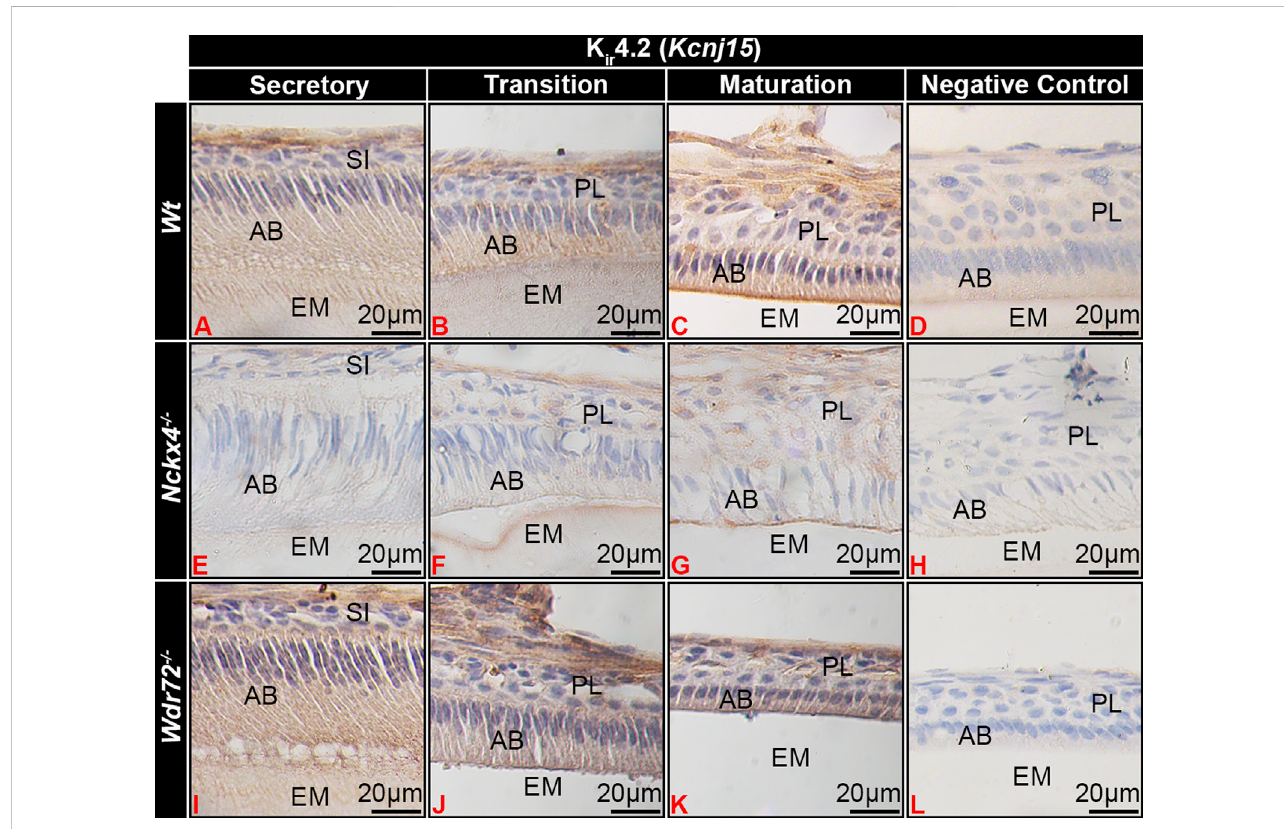
FIGURE 4 Kir4.2 immunostaining of ameloblasts. (A) Wt secretory ameloblasts (SAB) had minimal immunostaining for Kir4.2 (Kcnj15). (B) Transition stage ameloblasts(TAB) (B) hadpositiveKir4.2cytoplasmicstaining,which (C) localizedtotheapicalborderofruf fl e-ended(RE)early-stagematurationameloblasts (MAB) RE. In NCKX4 loss of function mice ( Nckx4 − / − ), Kir4.2 showed similar localization as compared to wt ameloblasts, with less intense immunostaining (E – G) . Intensity of Kir4.2 (Kcnj15) immunostaining in Wdr72 − / − mice was similar to that of wt mice, but was not localized to the MAB apical border or Wdr72 − / − mice (I – K) .NegativecontrolsforMABofeachmodel wt (D) , Nckx4 − / − (H) ,and Wdr72 − / − (L) wereimmunonegative. MAB, maturationameloblast; EM, enamel matrix; PL, papillary layer.